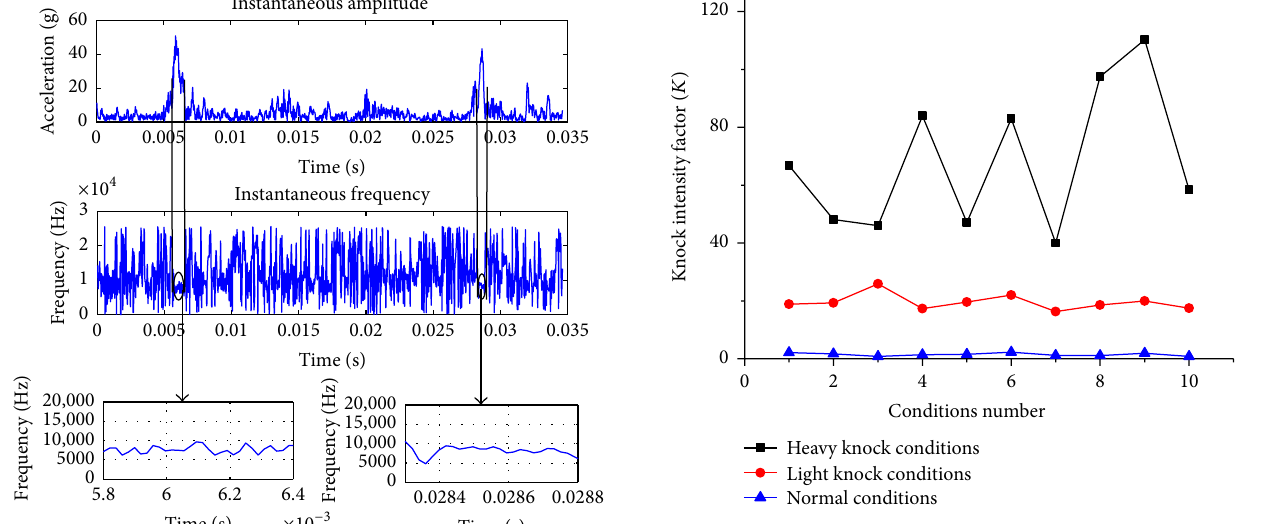
Figure 19: The knock evaluation parameter 𝐾 calculation results of vibration